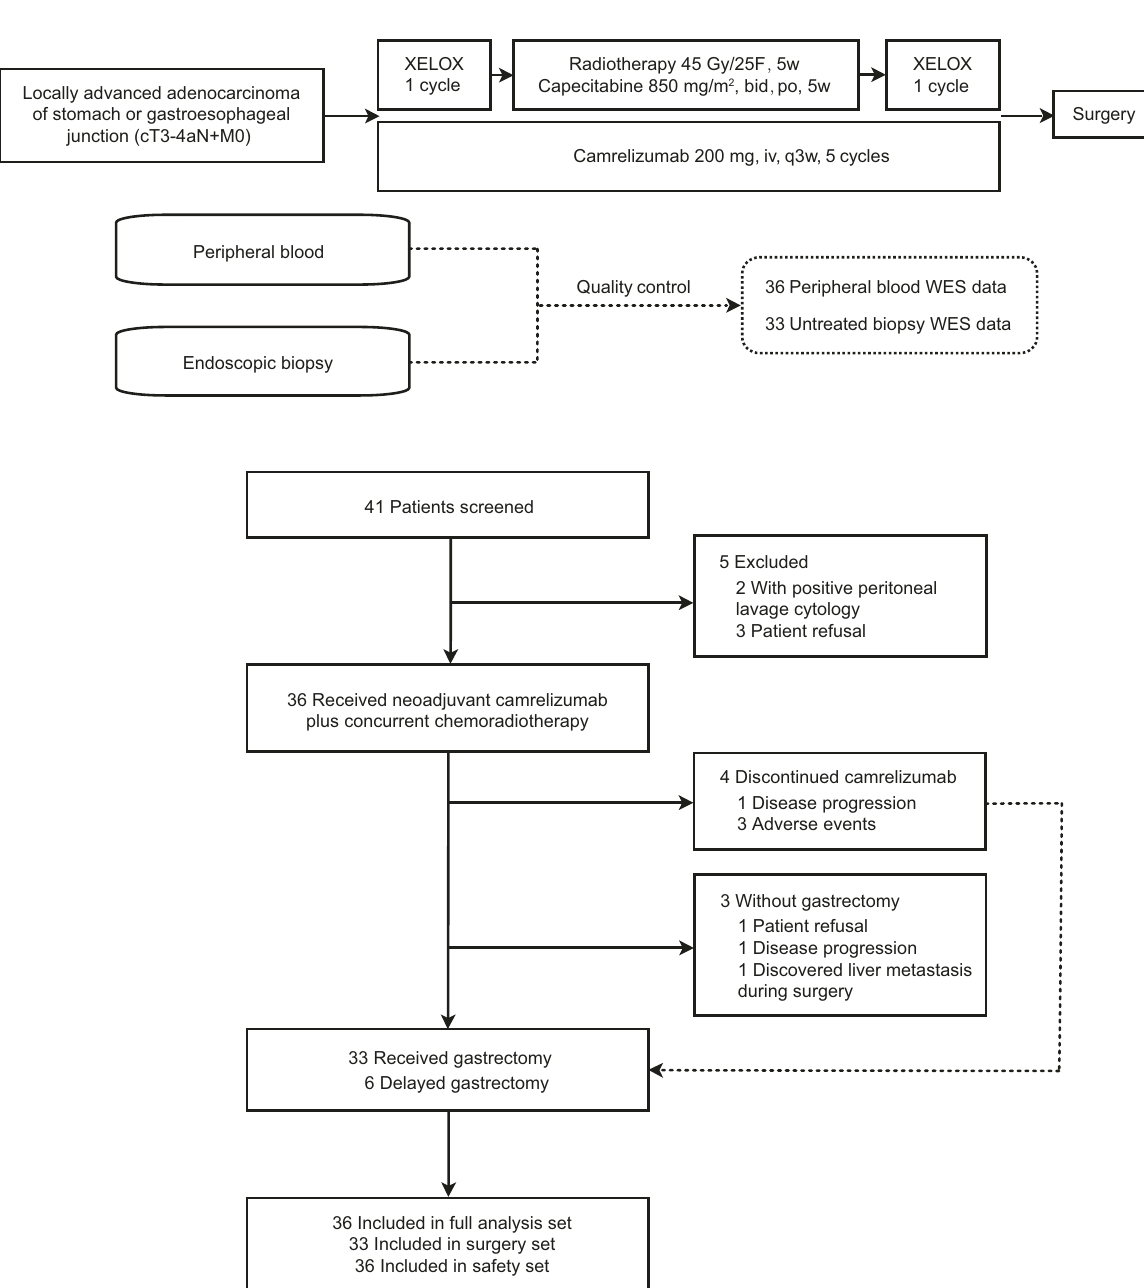
Fig.1|StudydesignandConsortdiagram.a Trialschemaandsamplecollection. b